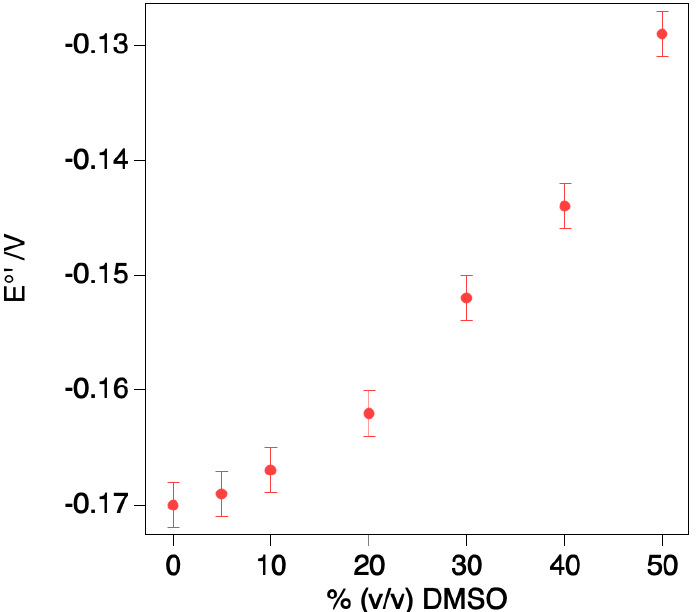
Figure 3. Dependence of the standard reduction potential E°’ on the % DMSO for the freely diffusing M80A variant of yeast cytc.